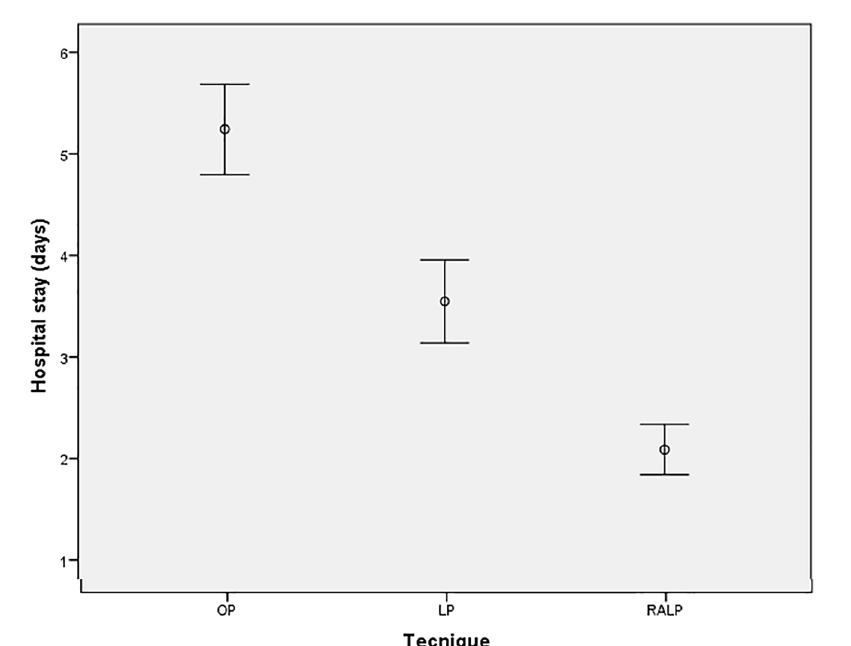
OP = Open Pyeloplasty; LP = Laparoscopic Pyeloplasty; RALP = Robotic-assisted laparoscopic pyeloplasty